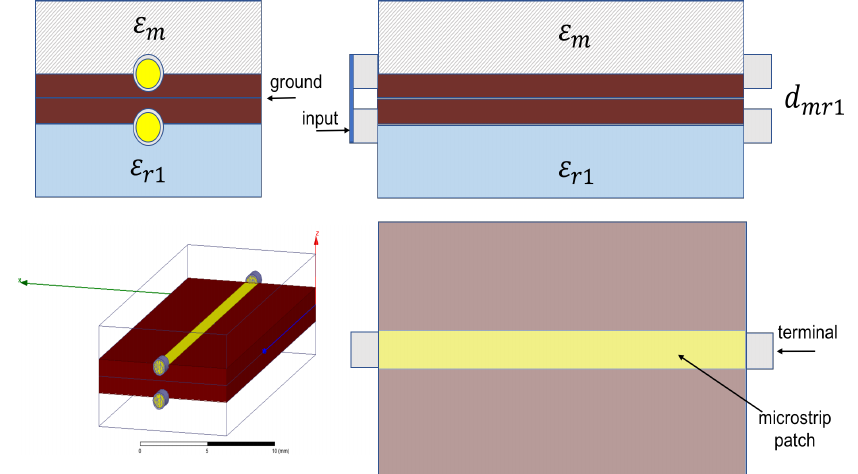
Figure 14. Microstrip line used as a sensor to detect permittivity levels of unknown material. Microstrip patch can have different dimensions and forms.